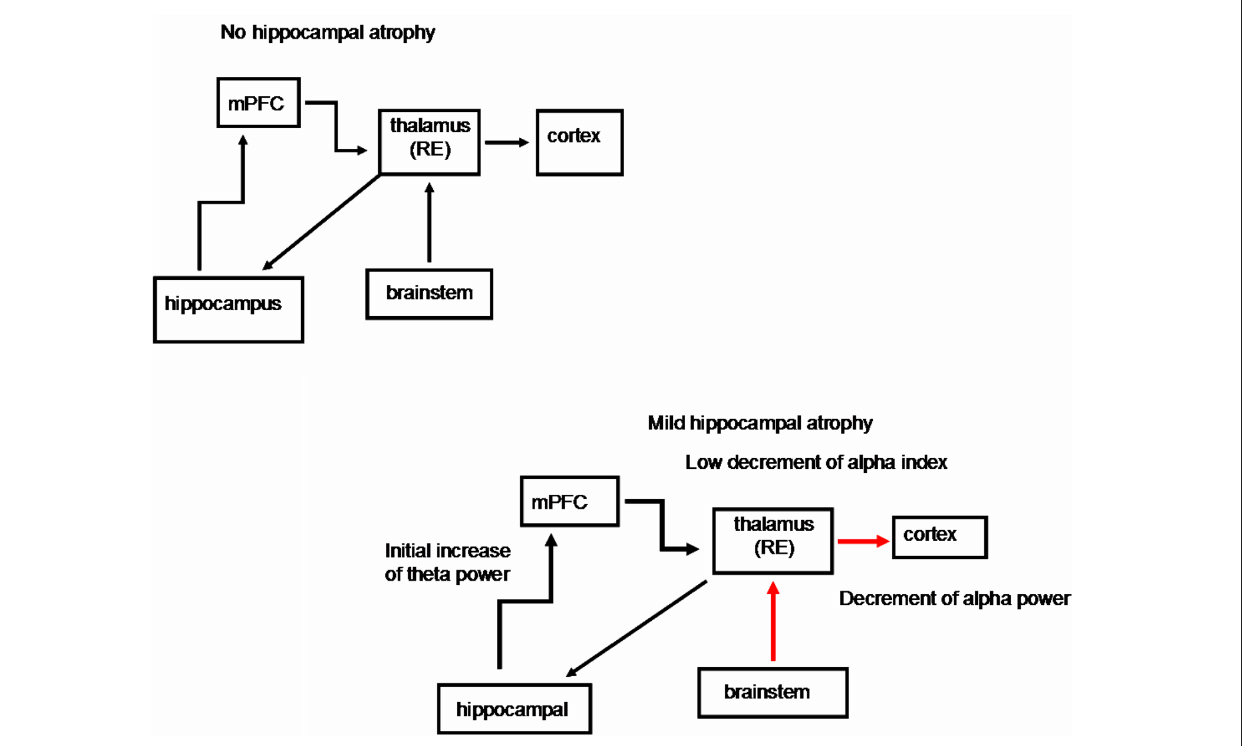
FiGurE 2 | Schematic diagrams of the possible structures involved in the thalamo-cortical arrhythmia in groups without hippocampal atrophy and with mild hippocampal atrophy. The EEG changes in the mild hippocampal- atrophy group are probably due to a prevalent depolarizing effect of the brainstem cholinergic system on the thalamus, because of initial neuronal loss in the